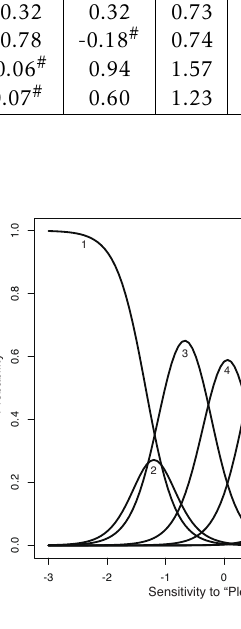
Figure 4. An example of operating characteristic curves (OCCs) for sub2 in Table 1.